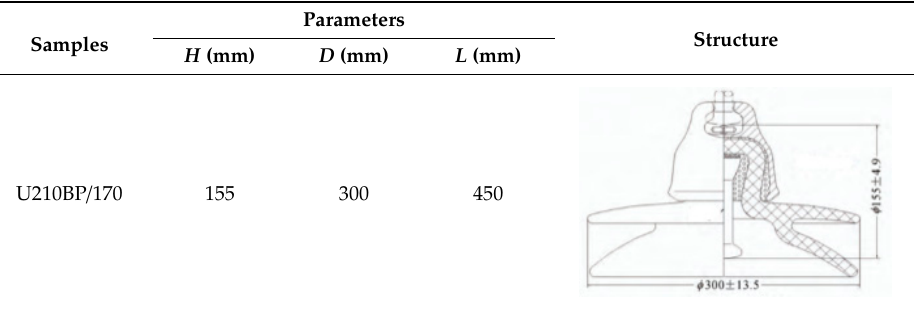
Table 1. Profile parameters of